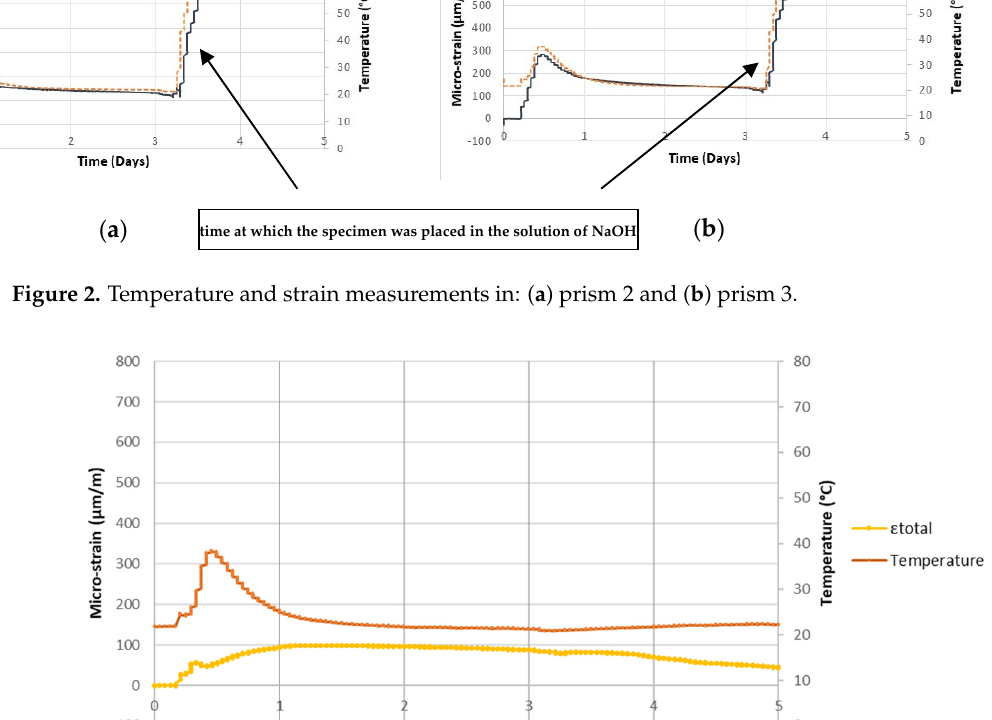
Figure 2. Temperature and strain measurements in: ( a ) prism 2 and ( b ) prism 3.